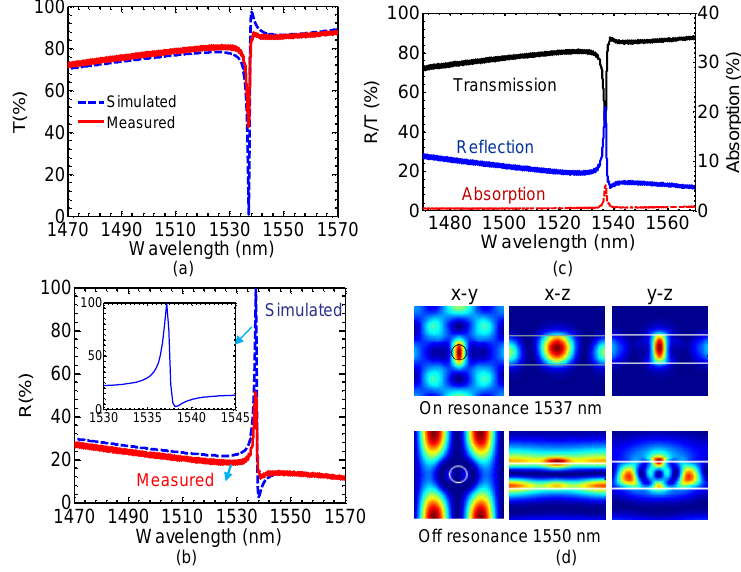
Figure 15. Measured and simulated ( a ) transmission and ( b ) reflection spectra of Si PCS transferred on glass substrate, with the inset in (b) showing the zoom-in of the simulated reflection resonance; ( c ) Measured transmission and reflection spectra, and derived absorption spectrum for the Si PCS on glass substrate, without graphene layer; and ( d ) Simulated field distributions for on-resonance and off-resonance modes. Reproduced with permission from